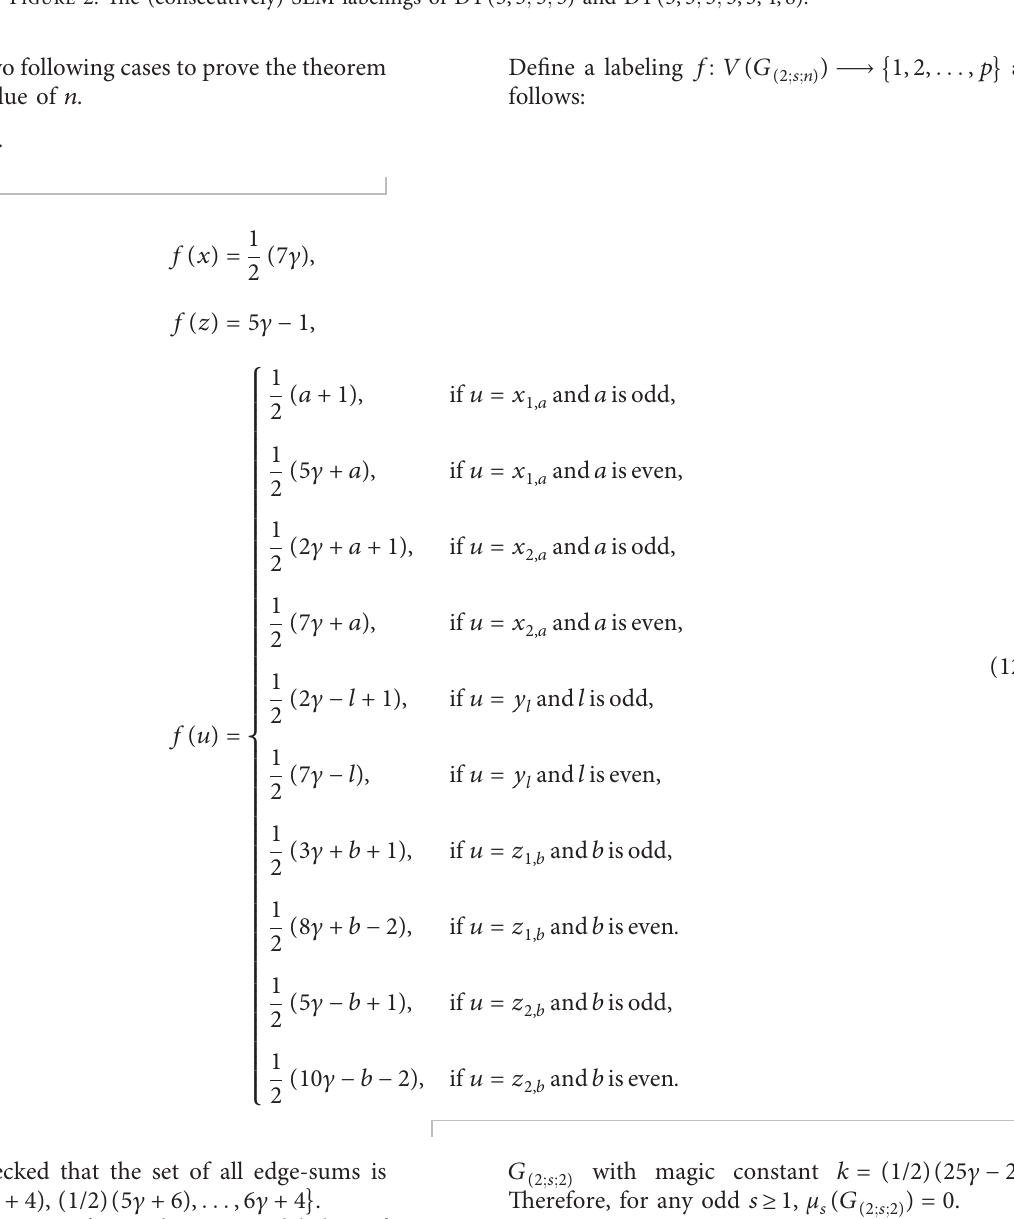
Figure 2: The (consecutively) SEM labelings of DT ( 5 , 5 ; 5 ; 5 ) and DT ( 3 , 3 ; 3 ; 3 , 3 , 4 , 8 )